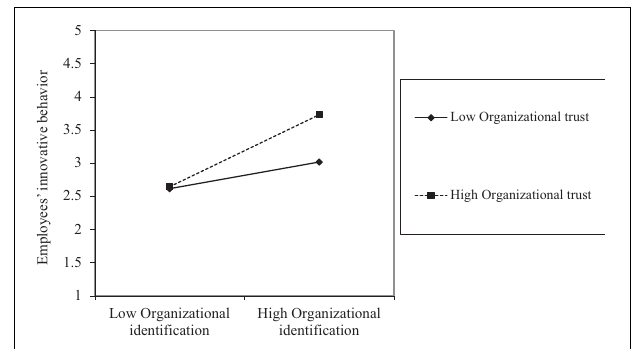
TABLE 6 | Conditional indirect effect of perceived ECSR on employees’ innovative behavior through organizational identification moderated by organizational trust.